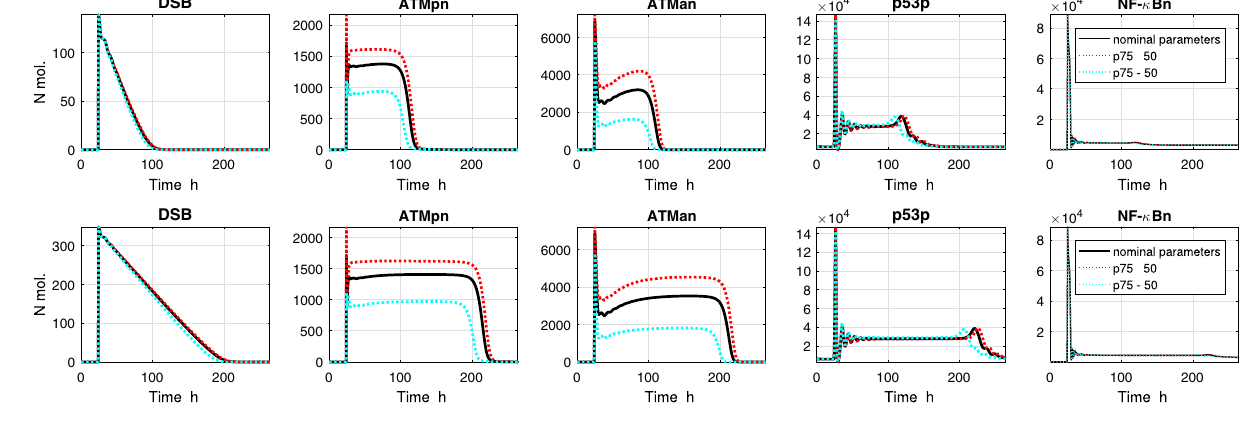
Figure 5. Impact of increasing/decreasing the value of the parameter ma 3 (par. No. 75) on the model’s response. Simulation was performed with two input signals: (TOP PANELS) 10 ng/ml TNF and 4 Gy IR; (BOTTOM PANELS) 10 ng/ml TNF and 10 Gy IR. TNF stimulation is constant during the simulation, IR radiation is turned on after 24 h simulation for 1 h.